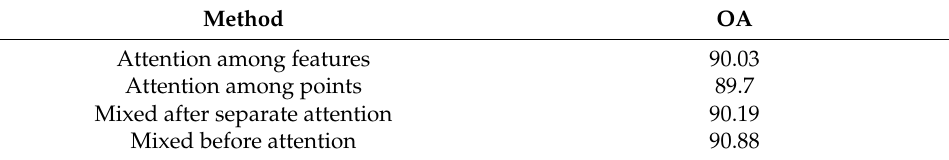
Table 4. The OA results of group